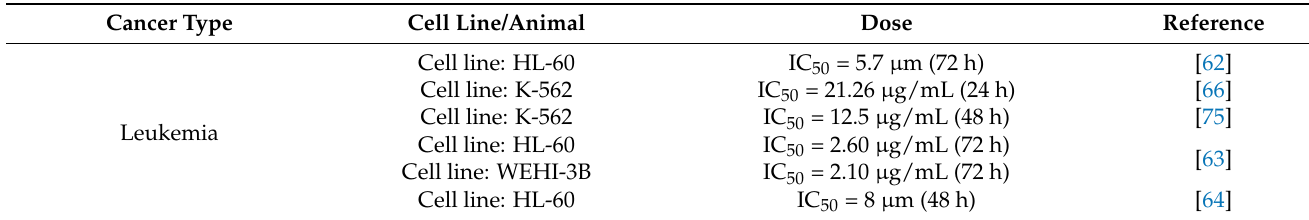
Table 1. Effect of BA on different cancer cell